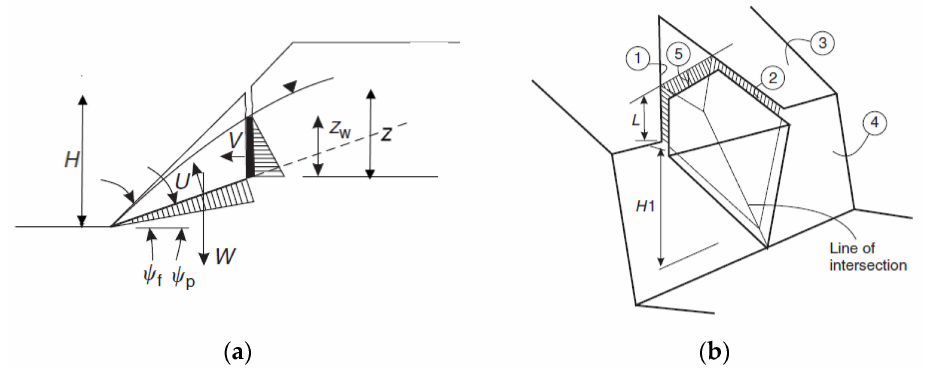
Figure 4. Models of ( a ) plane sliding and ( b ) wedge failure adopted for limit equilibrium analyses (figures from